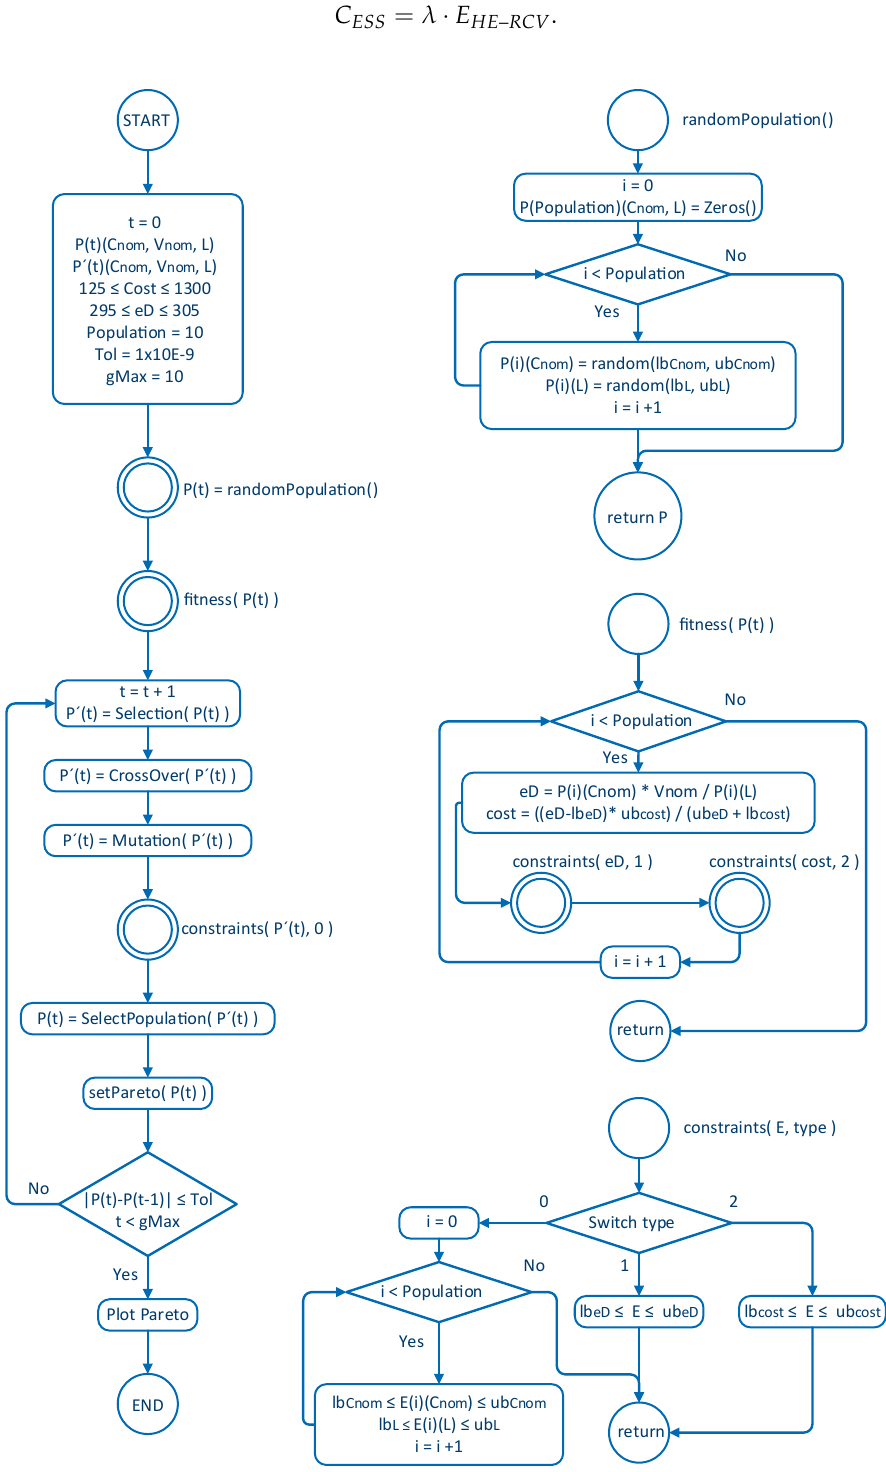
Figure 5. Multi-objective genetic algorithm to achieve a space of local optimal